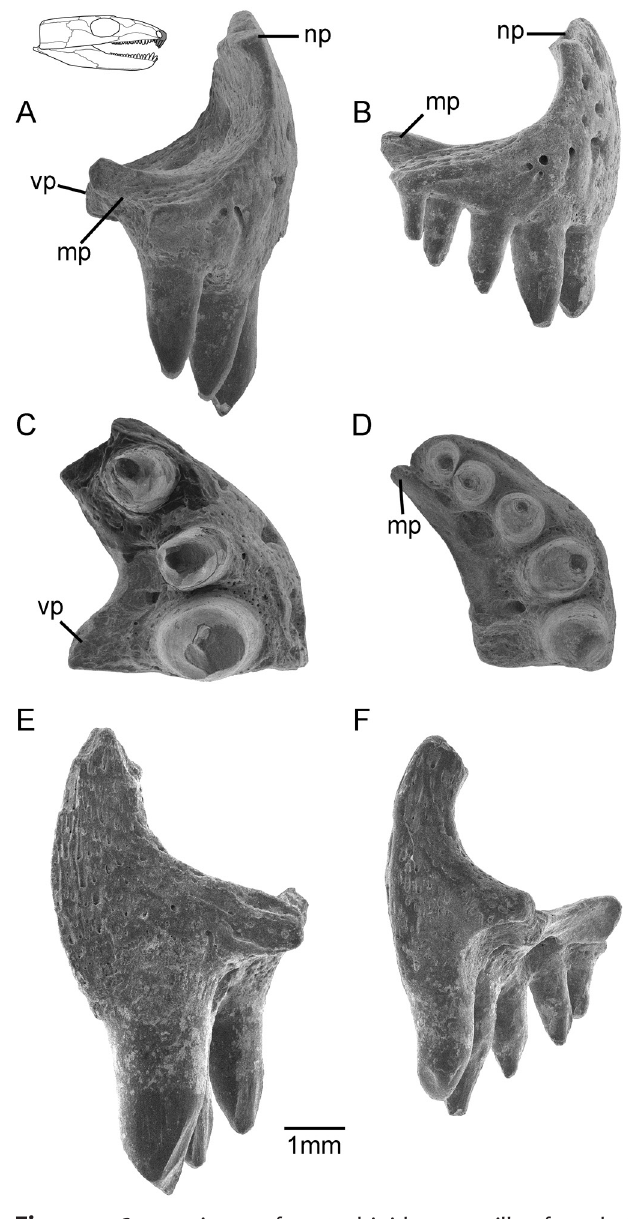
Figure 1. Comparisons of captorhinid premaxillae found